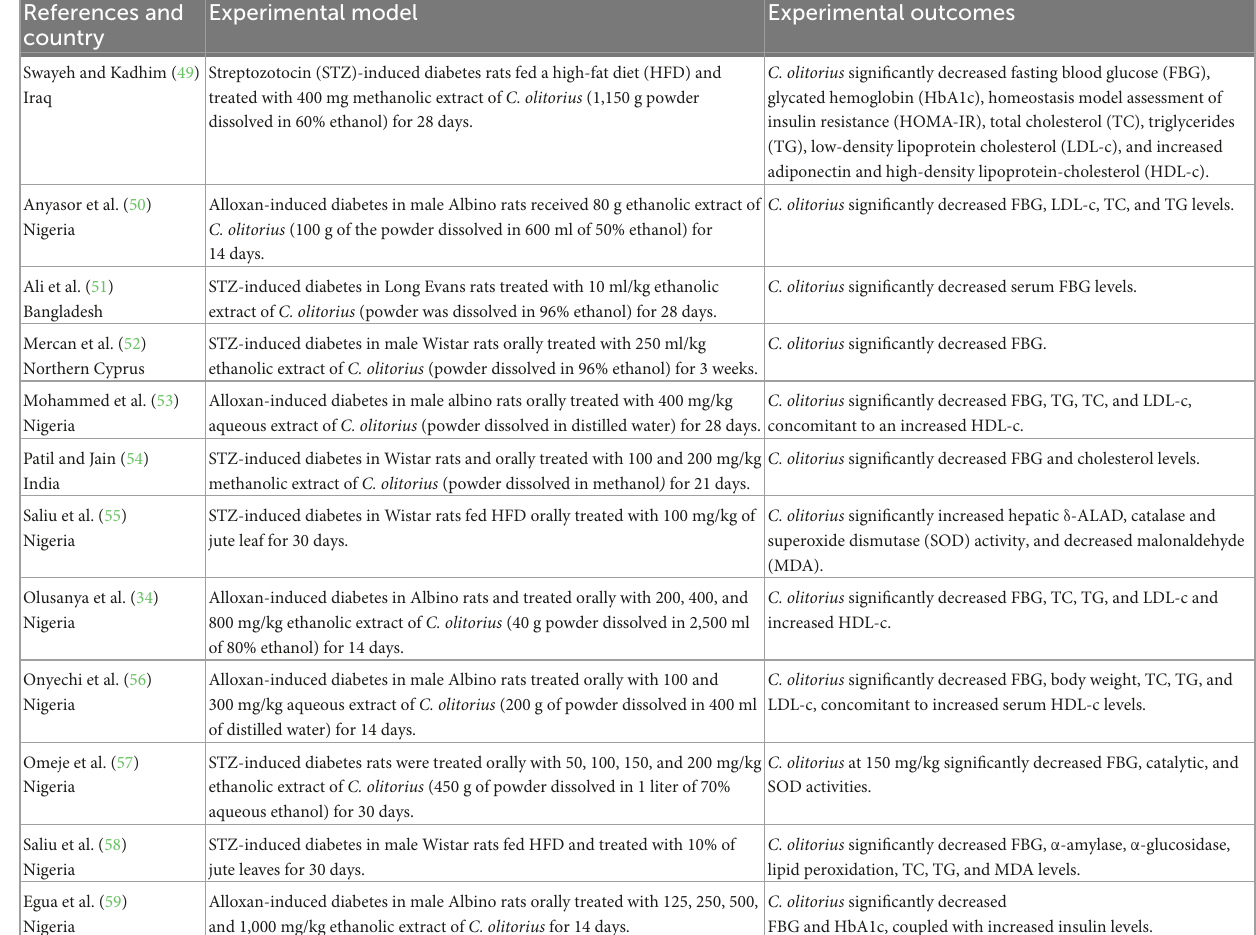
TABLE 2 A summary of studies evaluating the impact of Corchorus olitorius in rodent models of diabetes. References and Experimental model Experimental outcomes country Swayeh and Kadhim (49)